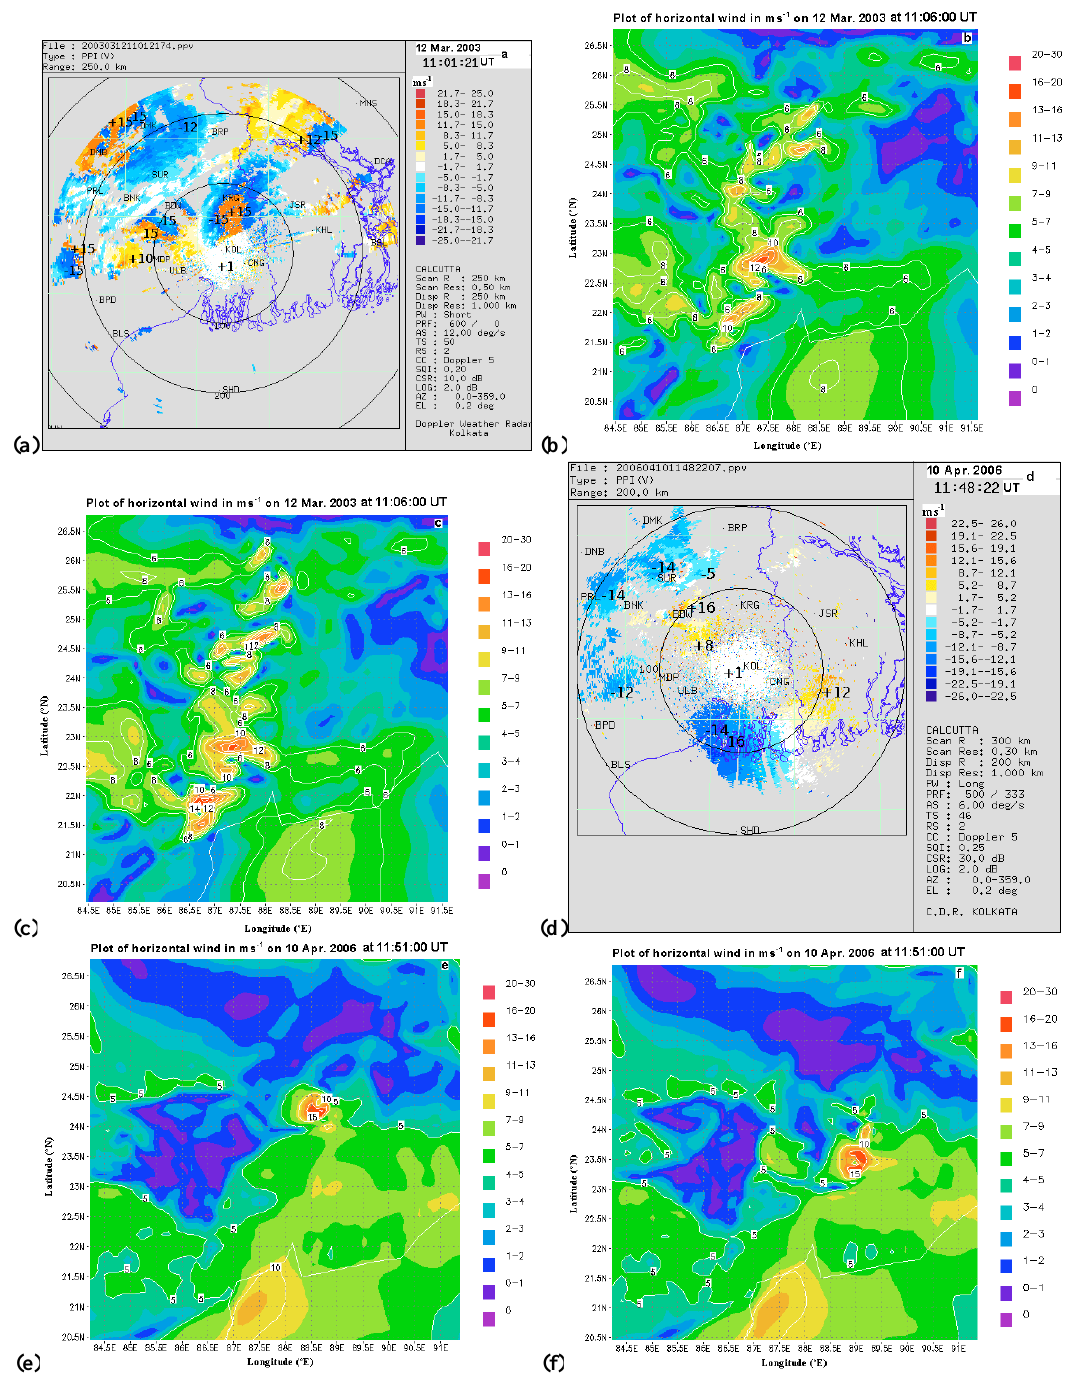
Fig. 4. (a) DWR derived wind PPI(V) at 11:01UT, 12 March 2003. (b) Model simulated wind with default microphysics scheme at 11:06UT, 12 March 2003. (c) Model simulated wind with modified microphysics at 11:06UT, 12 March 2003. (d) DWR derived wind PPI(V) at 11:48UT, 10 April 2006. (e) Model simulated wind with default microphysics scheme at 11:51UT, 10 April 2006. (f) Model simulated wind with modified microphysics scheme at 11:51UT, 10 April